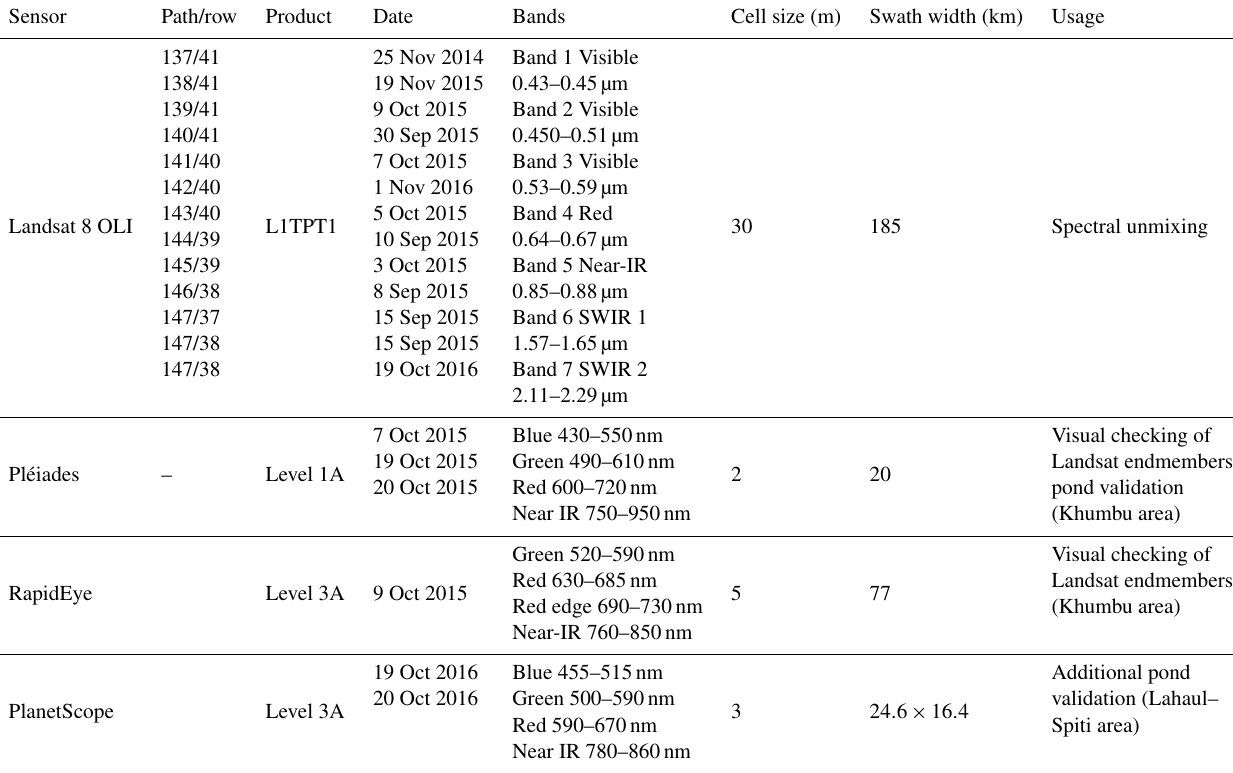
Table 1. Satellite imagery used in this study.